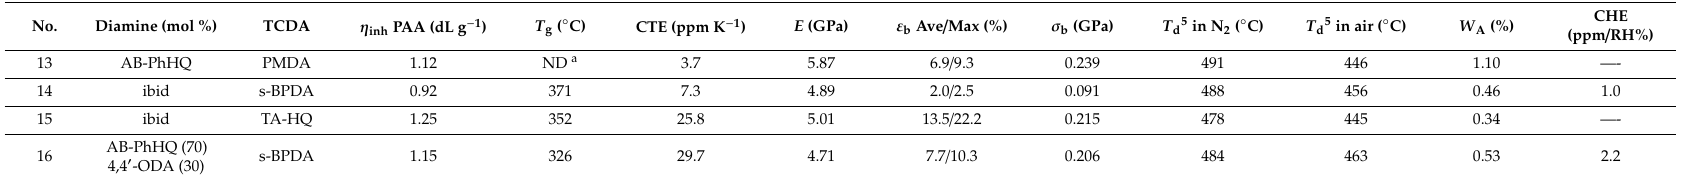
Table 4. Film properties of the PEsIs derived from AB-PhHQ (R = phenyl group) with tetracarboxylic dianhydrides (TCDA) and related copolymer.